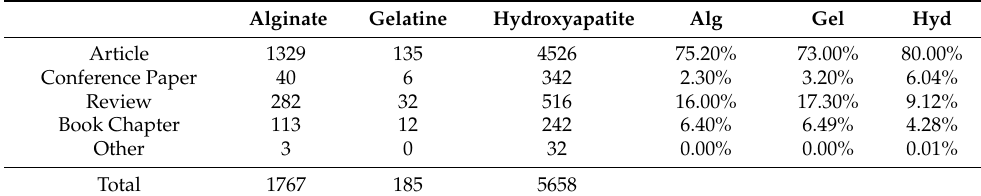
Figure 4. ( a ) Collaboration between countries on gelatine (2009–2019); ( b ). Collaboration between countries on alginate (2009–2019). Table 2. Types of published documents (2009–2019).